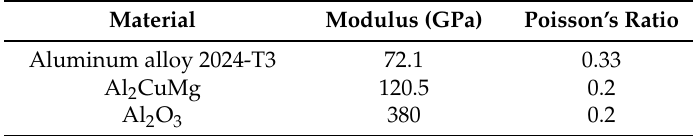
Table 1. The original material properties involved in this paper.